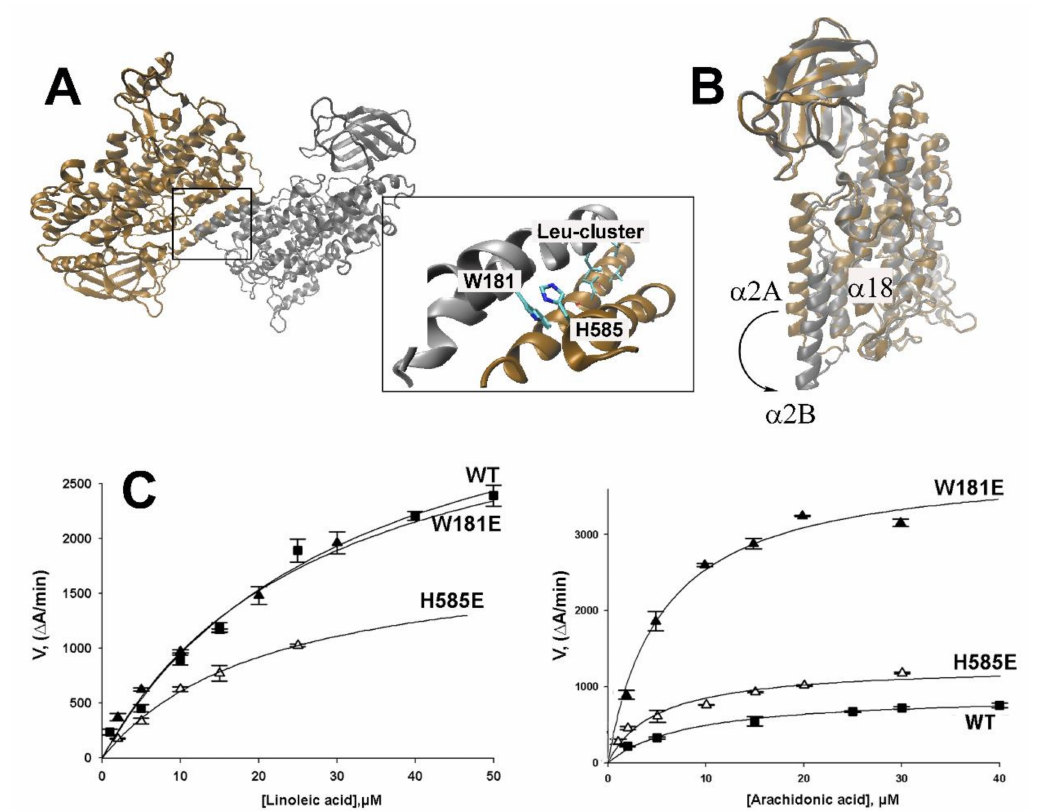
Figure 3. Contribution of Trp181 (W181) and His585 (H585) to the inter-monomer interface of rabbit ALOX15 and impact of mutations on the reaction kinetics of the enzyme. ( A ) Crystal structure of the rabbit ALOX15 heterodimer (PDB entry 2P0M) consisting of a ligand-free conformer A (brown) and a ligand-bound conformer B (grey). Inset: Amino acid residues contributing to the inter-monomer interface. ( B ) The two structures of the rabbit ALOX15. α 2 Helix of conformer A ( α 2A) is strongly dislocated when compared with conformer B ( α 2B). ( C ) Reaction kinetics of wild-type rabbit ALOX15 and of two enzyme mutants. Linoleic (left panel) or arachidonic acid (right panel) oxygenation was assayed spectrophotometrically (increase in absorbance at 235 nm) at different substrate concentrations. For each measurement 56 nM LOX (final enzyme concentration) normalized to the iron content was